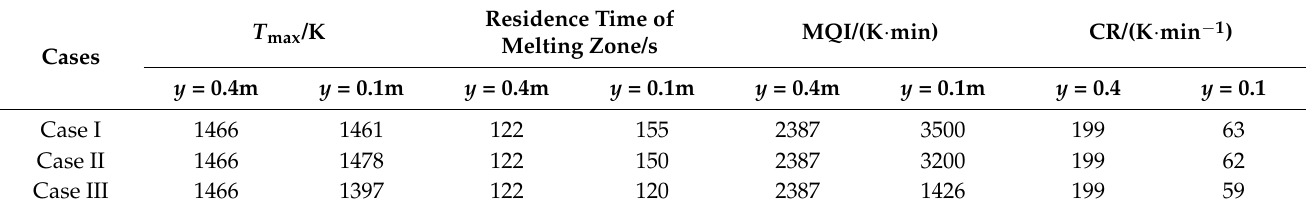
Table 6. Some parameters obtained from the temperature curves for cases I, II, and III.